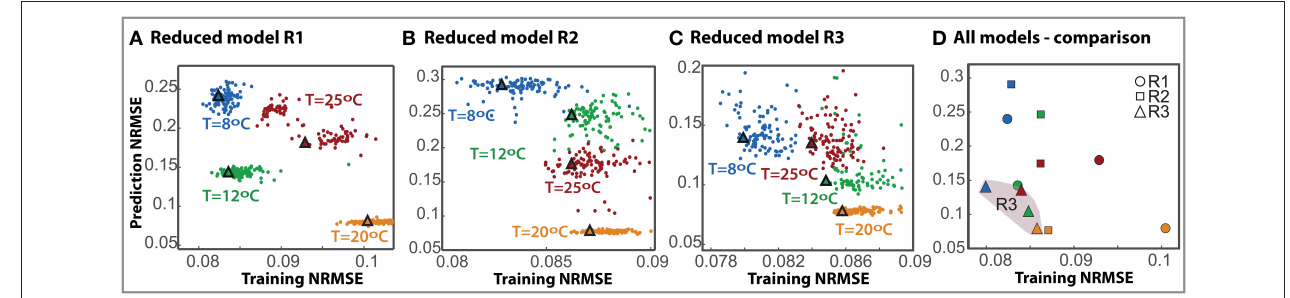
FIGURE 2 | Cross-validation for the selected reduced models. The prediction RMSE is plotted here against the training RMSE for each individual model (dots) and the ensemble (triangle) with different colors owing to different cross-validation scenarios. (A–C) Correspond to models R1, R2, and R3 respectively. (D) Presents the comparison of all three model